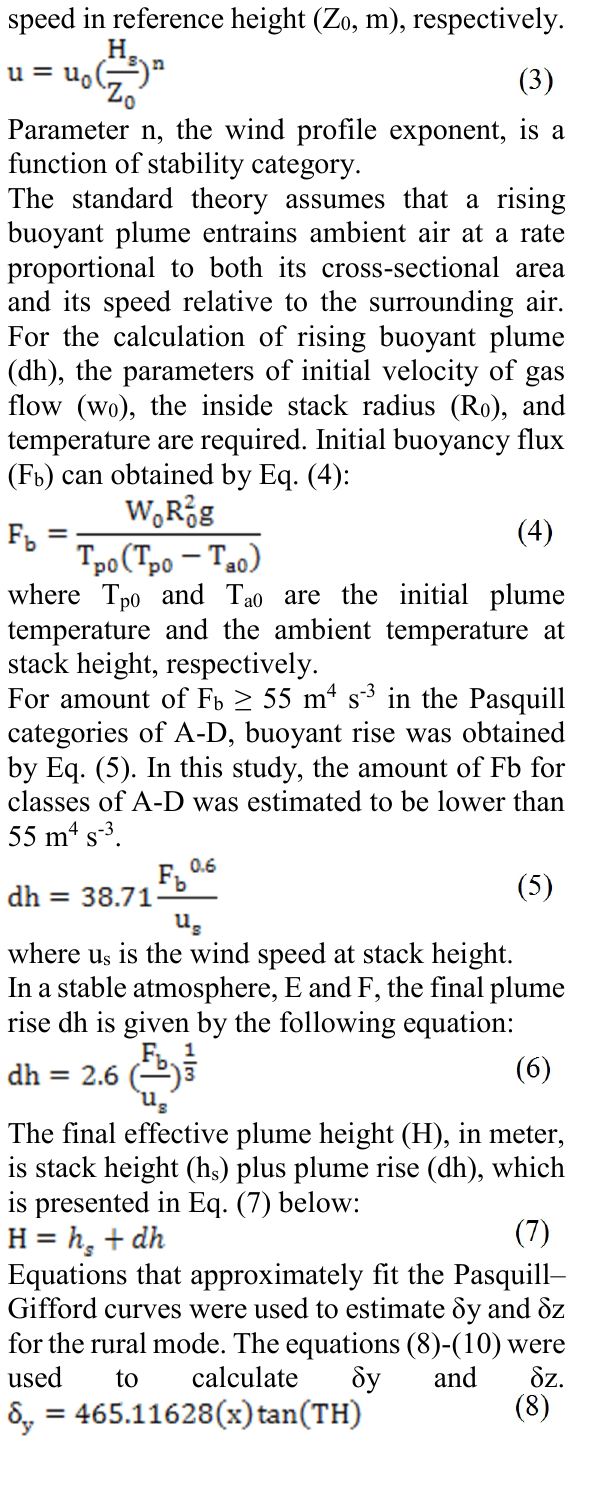
Table 1. Physical factors related to the three stacks of cement factory Physical factors of